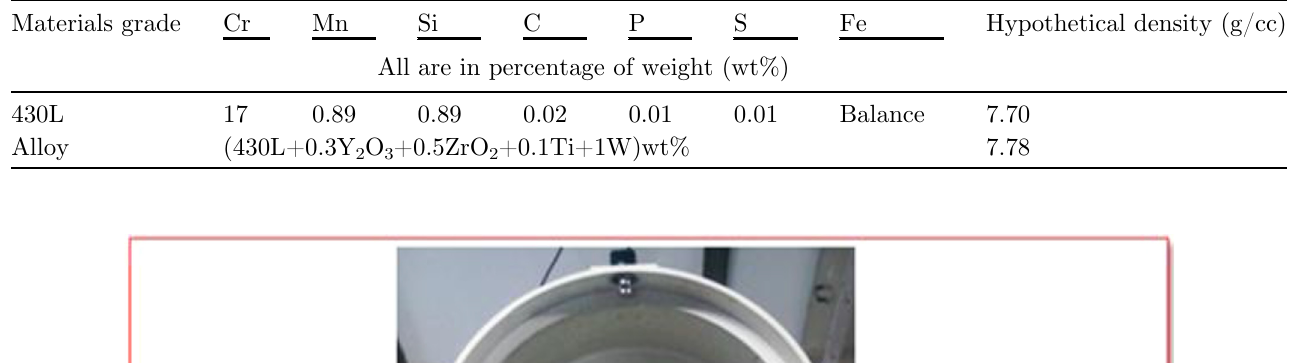
Table 1. Composition of ferritic stainless steel and its mixture. Materials grade